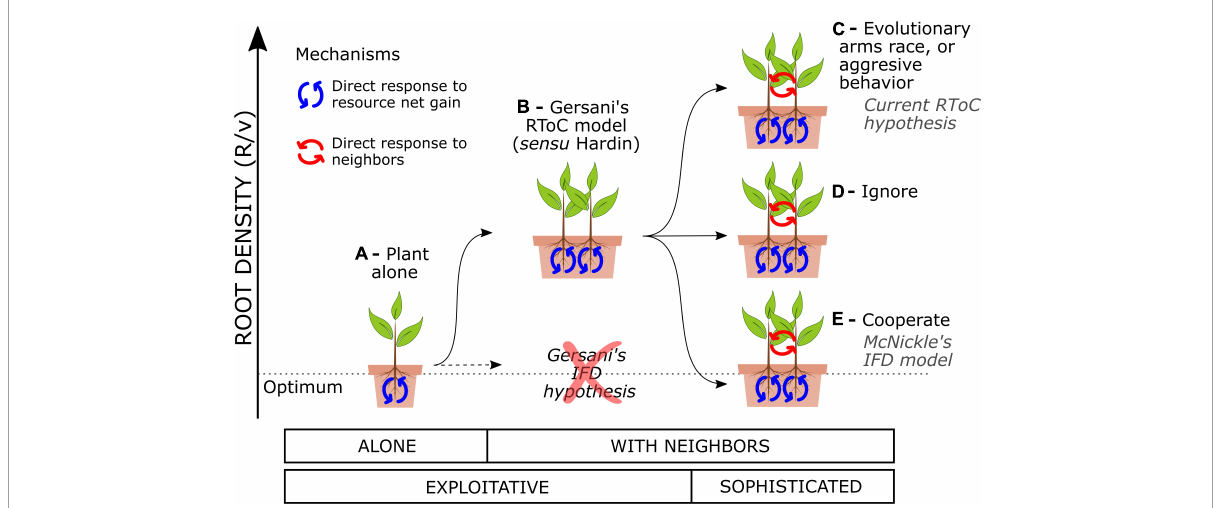
FIGURE1 Collective root density in soil as a function of varying the interaction setup and the type of plants. (A) An exploitative plant alone may tend to an optimal root density in equilibrium with the resource dynamics. (B) Interacting exploitative plants engage in an RToC ( sensu Hardin). Sophisticated plants can directly detect their neighbors and tune their exploitative response in any direction: (C) aggressively, overproliferating roots above the RToC (called also an RToC in modern studies), (D) ignoring their neighbors in terms of root density, or (E) cooperating and approaching and optimal collective root density (sometimes called an IFD in modern